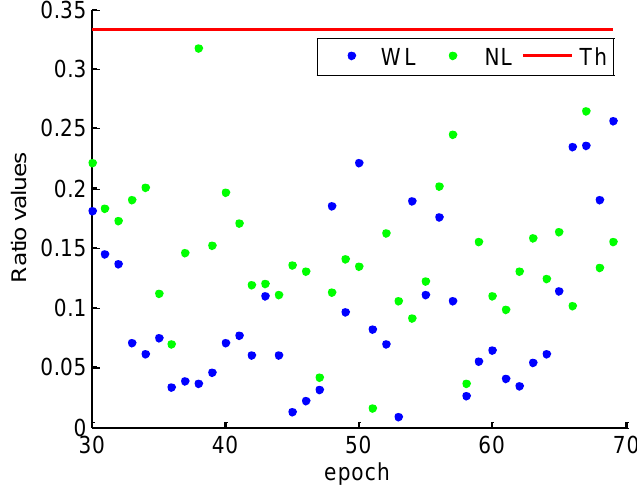
Figure 7. WL and NL ratio values for 180 s.